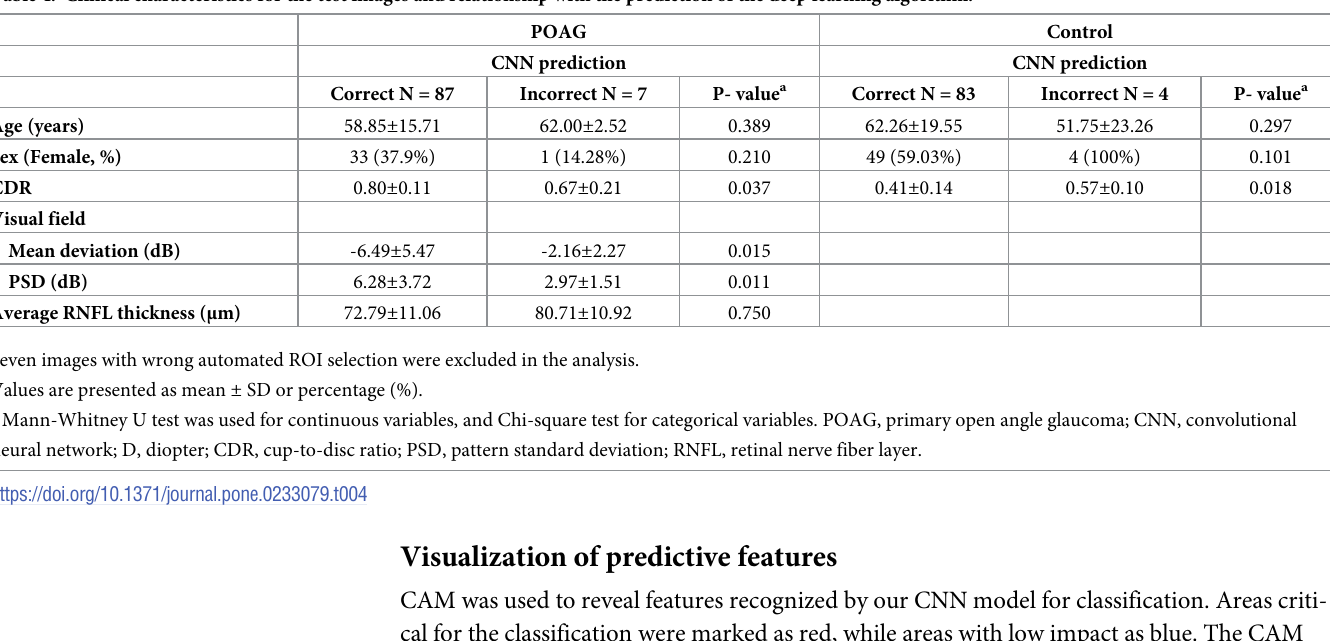
Table 4. Clinical characteristics for the test images and relationship with the prediction of the deep learning